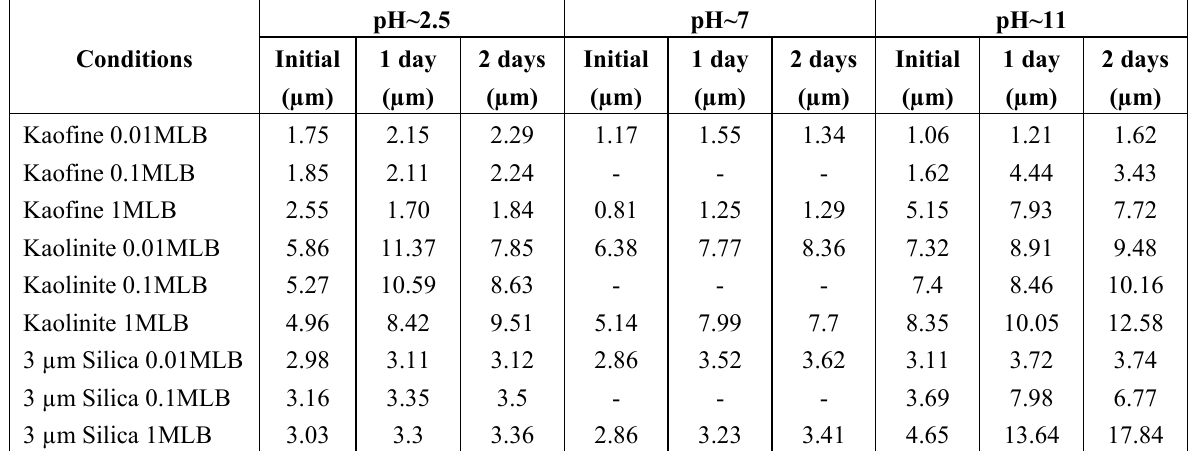
Table 2. Average particle size determined through light